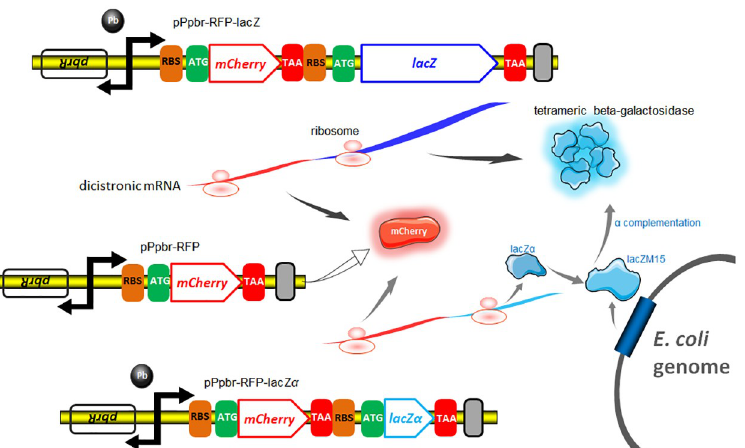
Fig 5. Genetic organization of three different lead biosensors. Based on a dicistronic pPpbr-RFP-lacZ, both mCherry and active β -galactosidase are expressed with Pb(II) induction. Based on a monocistronic pPpbr-RFP, only the mCherry reporter is expressed with Pb(II) induction. Based on a dicistronic pPpbr-RFP-lacZ α , the mCherry reporter and lacZ α are expressed under the control of a target pbr promoter driven by Pb(II), and lacZM15 is synthesized under the control of a host lac promoter driven by IPTG. After active tetrameric β -galactosidase is finally assembled in the host cell, both fluorescent signal and enzymatic activity are then determined.